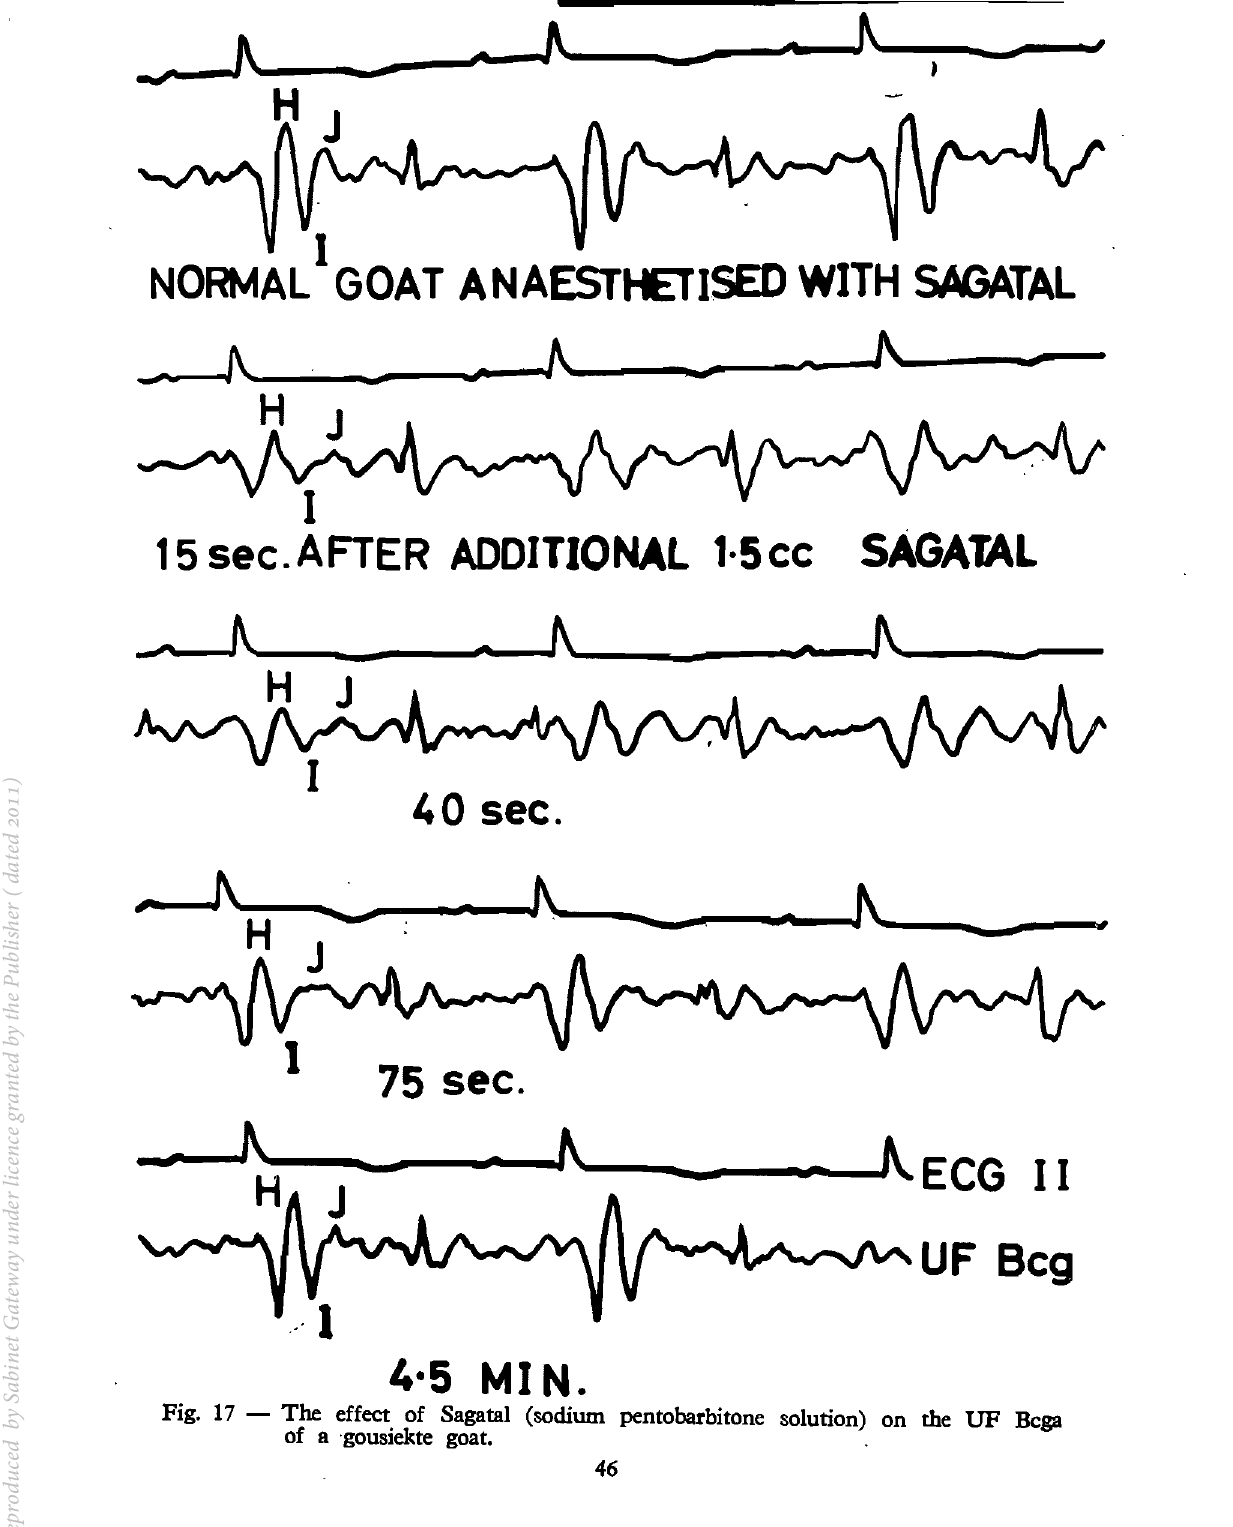
Fig. 17 - The effect of Sagatal (sodium pentobarbitone solution) on the UF Bcga of a ·gousiekte goat. .